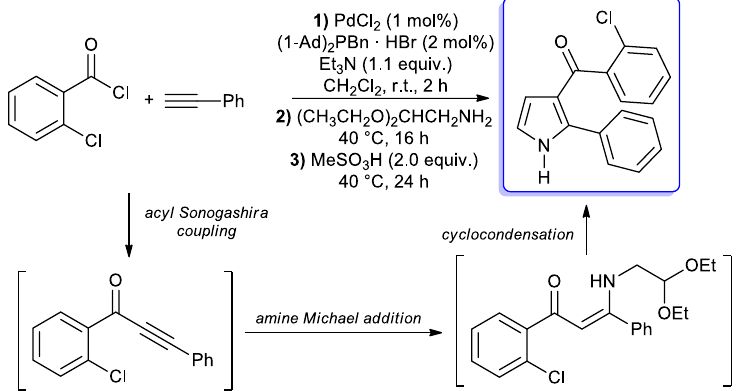
Scheme 22. Model reaction for the optimization of one-pot synthesis of 2-substituted 3-acylpyrroles.